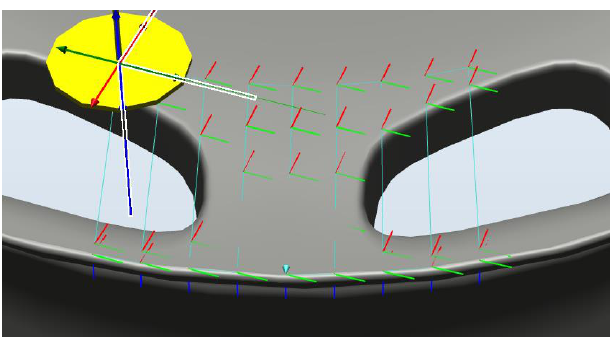
Figure 6. Simulated detection path.